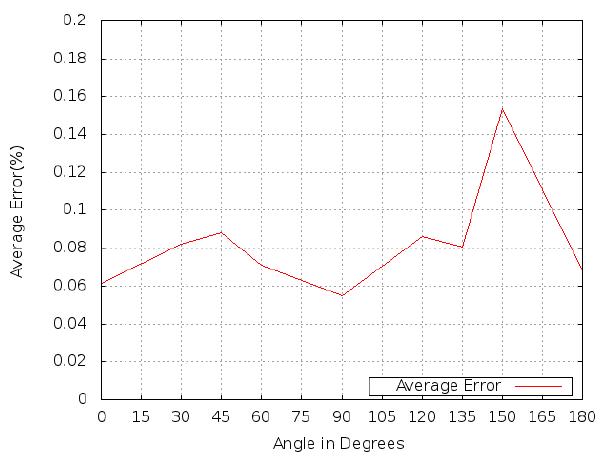
Figure 17. Average error variation with change in start angle